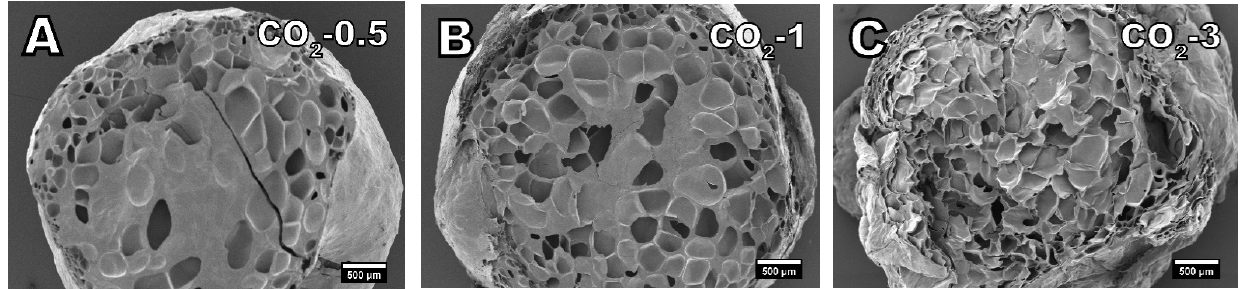
Figure 3. SEM images of samples foamed with isobutane in amounts of ( A ) 1%, ( B ) 3%, and ( C ) 5%. (15× magnification).